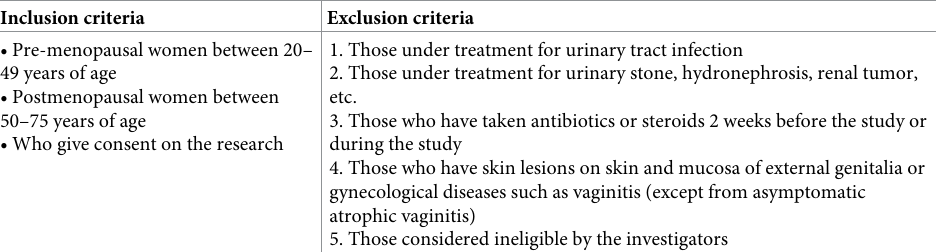
Table 1. Inclusion and exclusion criteria of the